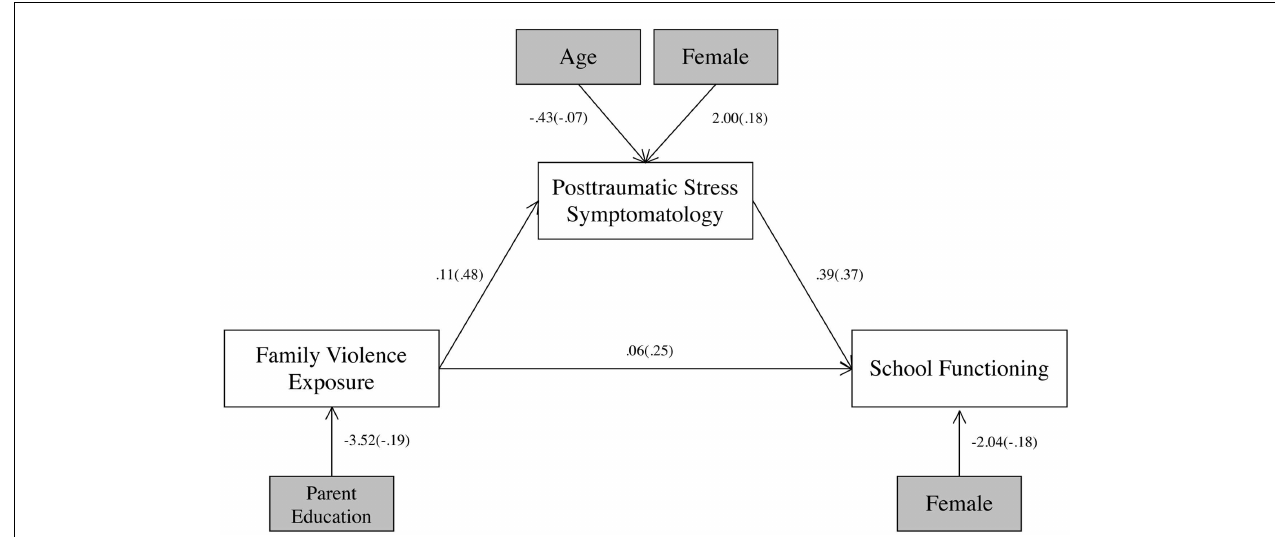
FIGURE 2 | Family violence, PTS, and school functioning problems . All paths were significant ( p < 0.05). Unstandardized path coefficients are listed, followed by standardized path coefficients in